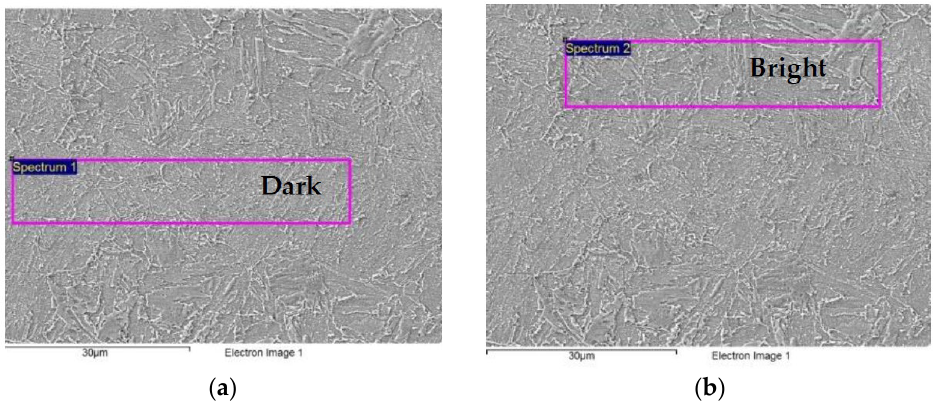
Figure 5. Scanning electron microscope SEM images of microstructure in dark ( a ) and bright ( b ) bands. In these pictures shown areas for the local chemical composition determination (magenta). Table 2. Chemical composition in dark and bright bands (for Figure 5), wt. %.